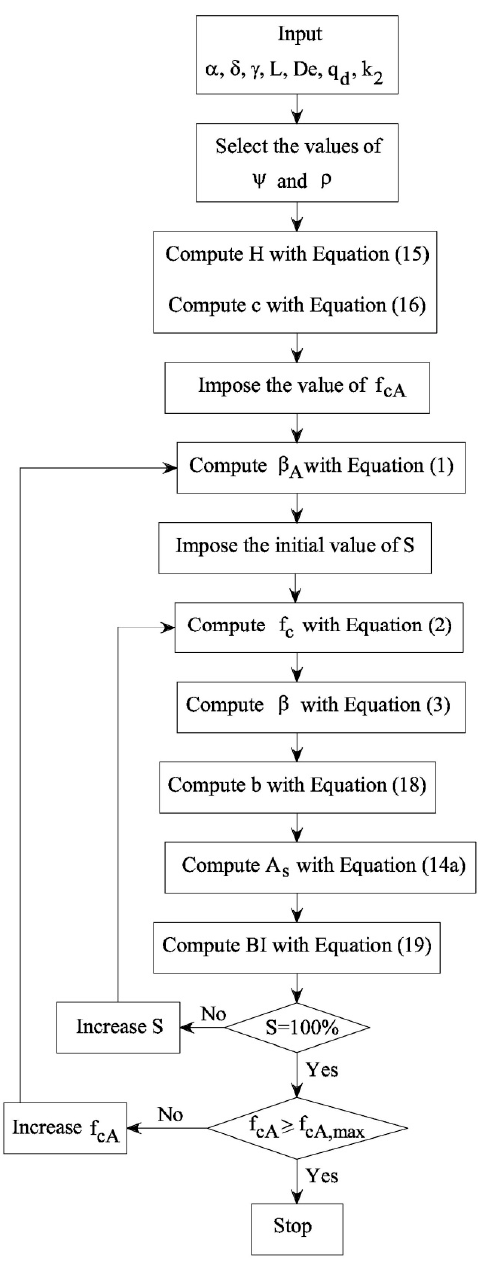
Figure 5. The procedure to compute the functions β - S , b - S , A s - S , and BI - S in concrete systems with an average compressive strength in the absence of cement substitution lower than f cA,max .